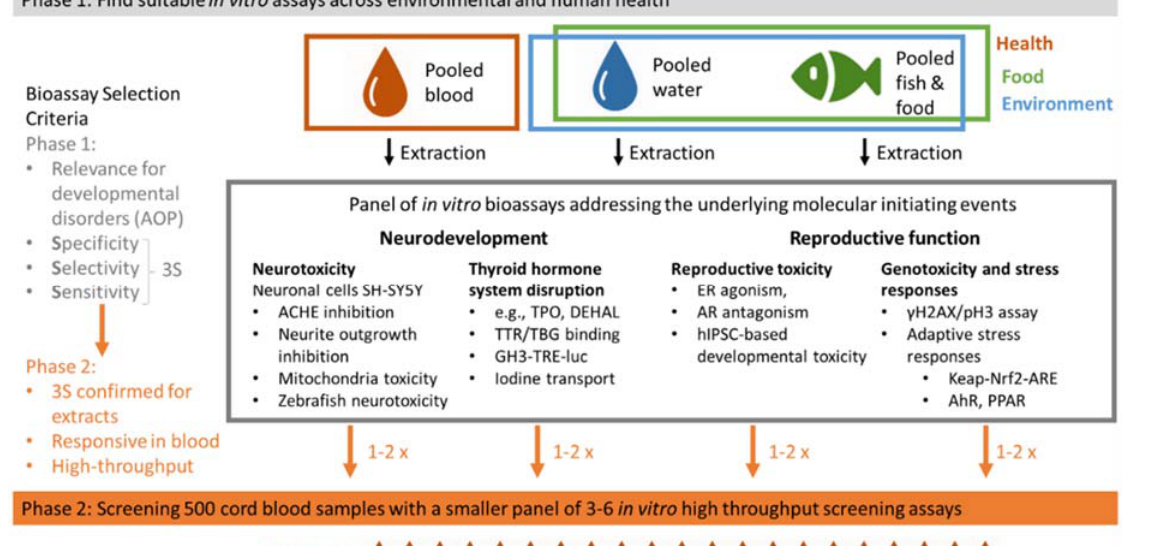
Figure 2. Overview of Phases 1 and 2 of the workplan for whole mixture screening based on high-throughput in vitro new methodological approaches. Pooled blood/water/fish/food: samples from a large number of European countries or European individuals are pooled, and thereafter the chemicals are extracted from the pools. ACHE: acetylcholinesterase; TPO: thyroid peroxidase; TTR: transthyretin; TBG: thyroid hormone binding globulin; GH3-TRE-luc: reporter gene bioassay that can measure thyroid hormone receptor mediated activity; ER: estrogen receptor; AR: androgen receptor; hIPSC: human ‐ induced pluripotent stem cells; Nrf2: nuclear factor erythroid 2–related factor 2; AhR: arylhydrocarbon receptor; PPAR: peroxisome proliferator ‐ activated receptor.